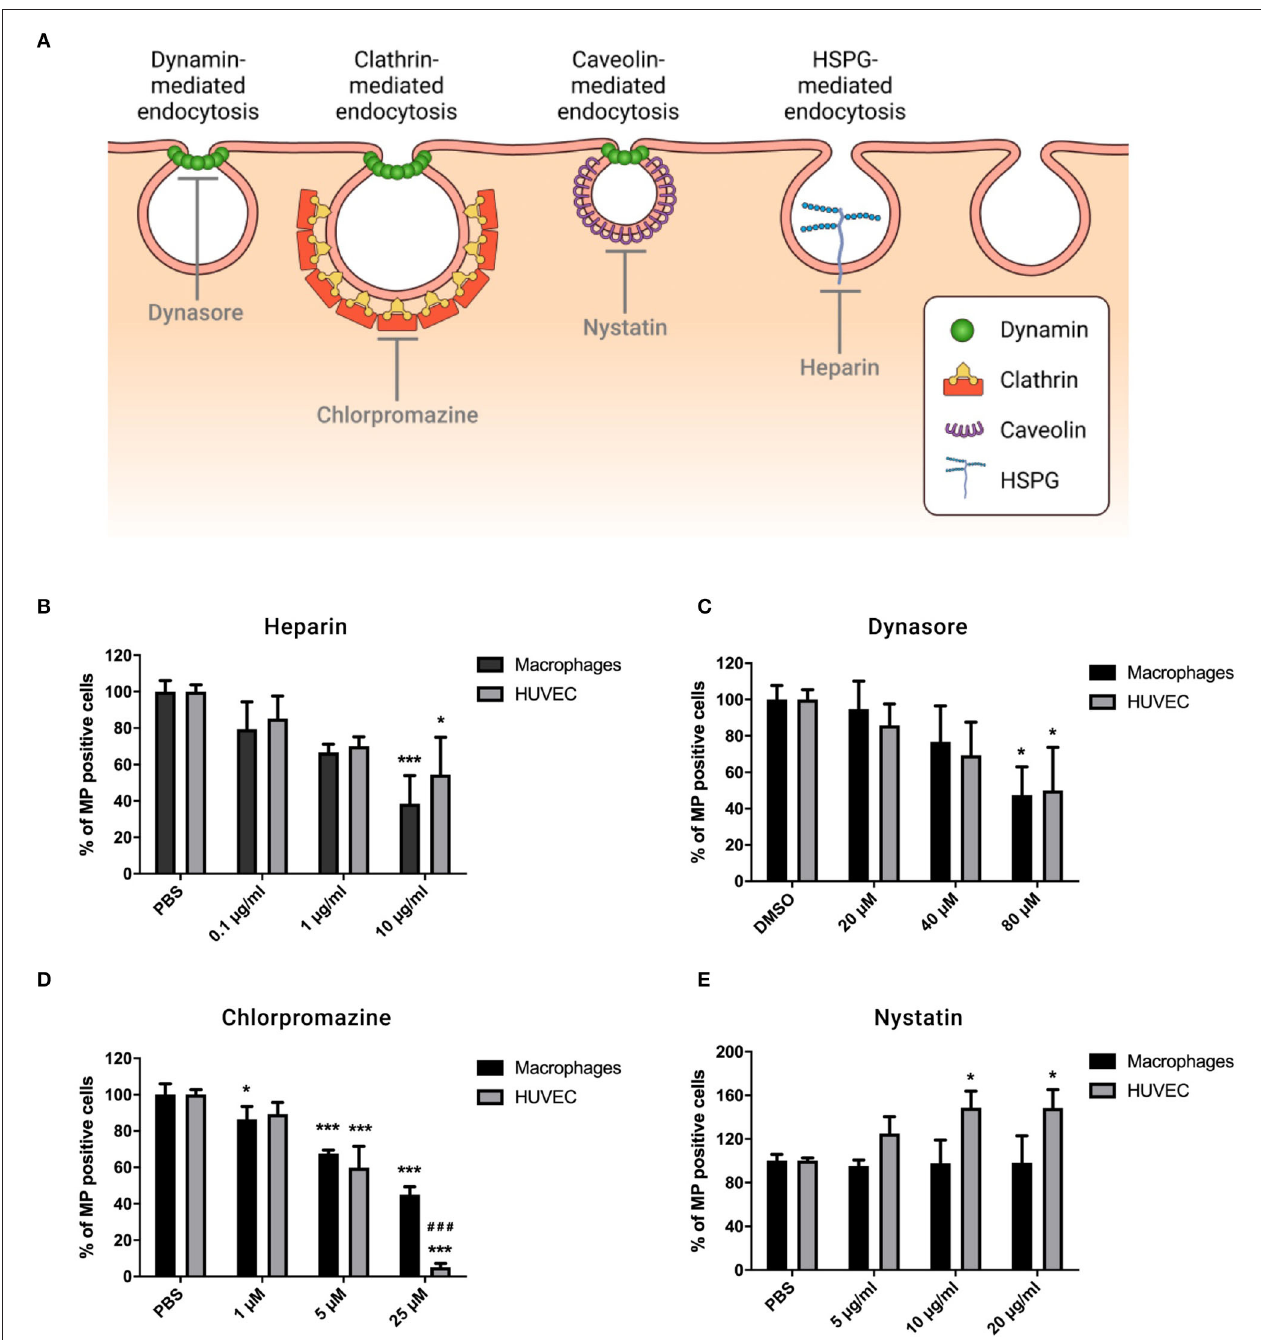
FIGURE 3 | MP uptake by macrophages and HUVEC depends on HSPG-, dynamin-, and clathrin-mediated endocytosis. Cells were preincubated for 30min at 37 ◦ C in complete medium containing Heparin (0.1, 1, and 10 µ g/ml), Dynasore (20, 40, and 80 µ M), Chlorpromazine (1, 5, and 25 µ M), or Nystatin (5, 10, and 20 µ g/ml). PKH-MP were then added to cells (ratio 1:100,000) and analyzed after 6h by flow cytometer. PBS and 0.1% DMSO were used as a control. (A) Receptor-mediated endocytosis pathways. (B) Percentage of macrophages and HUVEC positive for PKH-MP in the presence of increasing concentrations of Heparin (B) , Dynasore (C) , Chlorpromazine (D) , and Nystatin (E) . Data are presented as mean ± SD from 4 to 6 experiments. * P < 0.05 and *** P < 0.001 vs. vehicle; ### P < 0.001 vs.